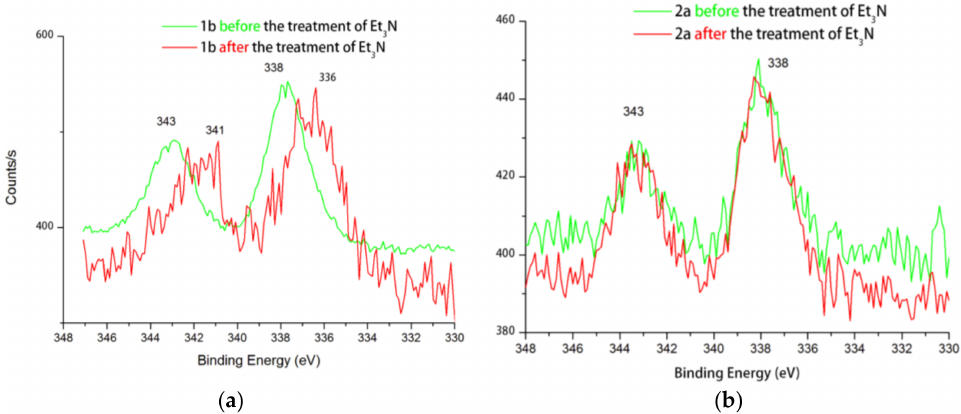
Figure 7. XPS spectra of the resins 1b ( a ) and 2a ( b ) before (green) and after (red) the treatment of resin by Et 3